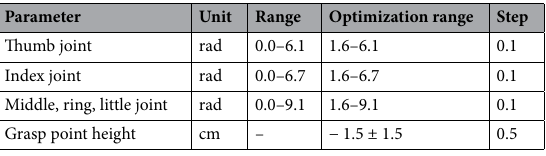
Table 1. The range of values and discretization step for each optimized